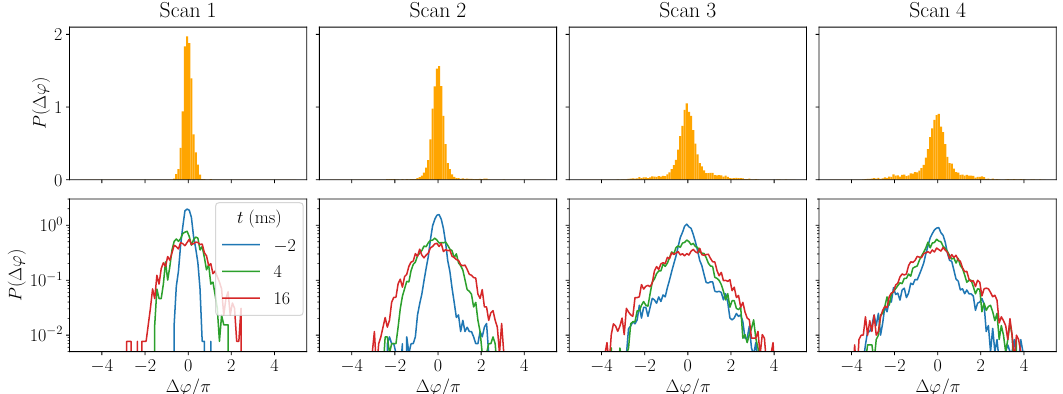
Figure 12: Histograms of the phase difference distributions and their dynamics for each of the four main experimental scans. Top : Histograms of the state just before the quench ramp ( t = − 2 ms). Scan 1 corresponds to a narrow bell-shaped distribution that is close to the Gaussian shape. Scans 2, 3 and 4, while still characterized by bell- shaped distributions in the center, progressively deviate from the Gaussian for larger ϕ , exhibiting long tails, as one would expect from thermal states of an interacting model with a cosine potential. Bottom : Histograms at different times in logarithmic scale: just before the quench ramp, at an intermediate time and at the last measured time. The plots are presented in logarithmic scale to facilitate the identification of the Gaussian bell shape (inverse parabola). The time t = 0 corresponds to the end of the quench ramp.